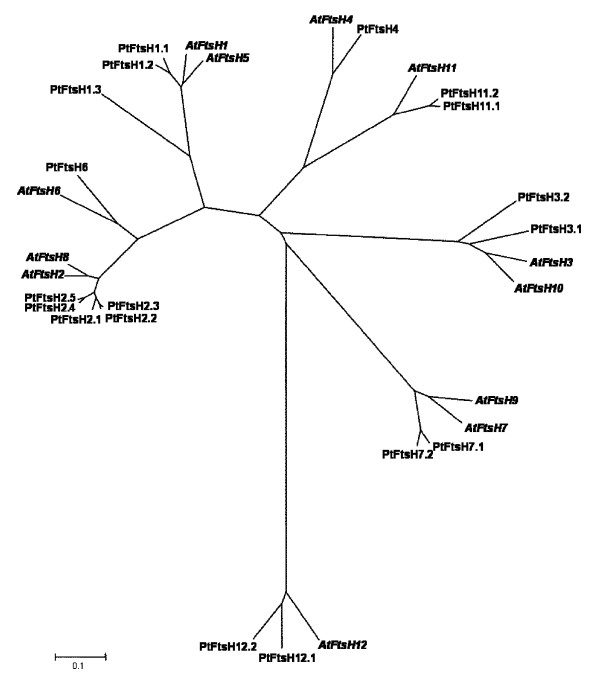
UPGMA (Unweighted Pair Group Method with Arithmetic Mean) tree of the FtsH protease family (M41 family in MEROPS). The names and the accession numbers for the different proteins are given in Table 2.